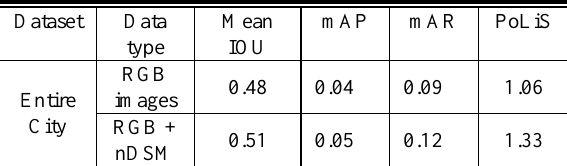
Table 2. Extraction results on the entire study area of the Enschede dataset. The mAP, mAR and PoLiS are calculated on the polygons with 1 pixel tolerance for polygonization.